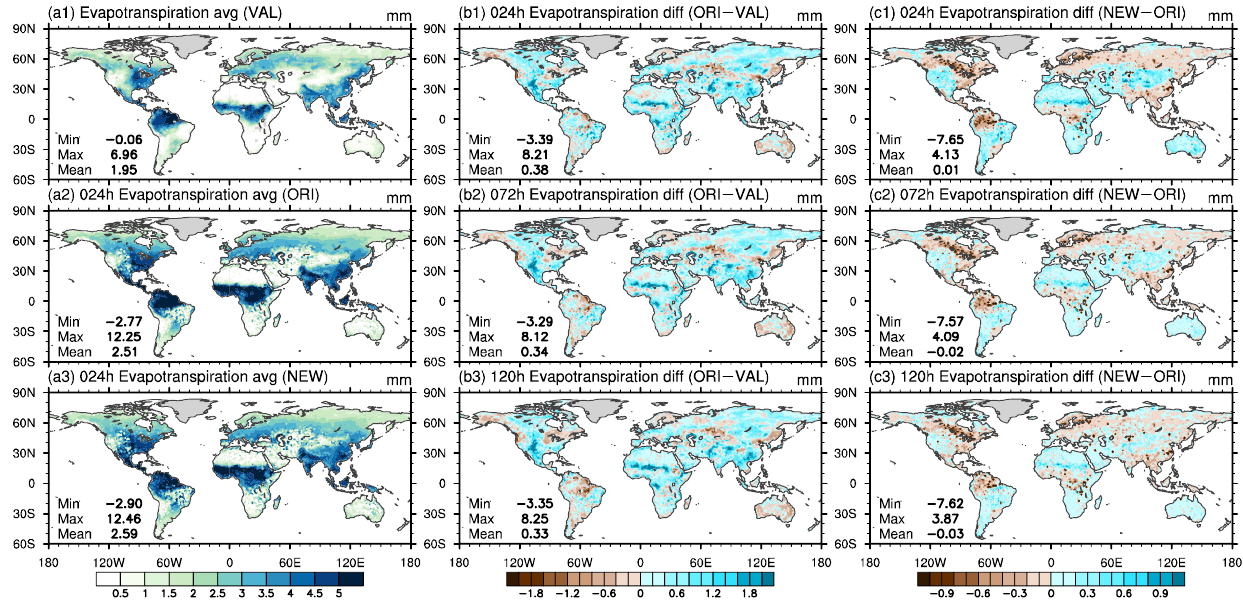
Figure 12. Same as Figure 9, but for 24 h net evapotranspiration (units: mm).